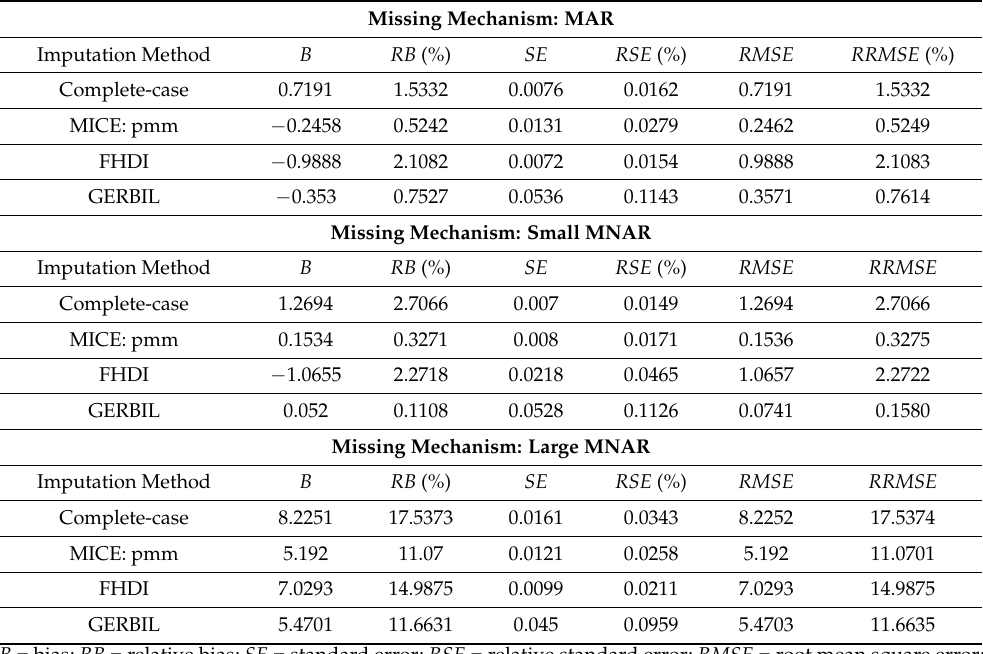
Table 1. Summary of Simulation Results for Mean of BRFSS Variable “Age when Diagnosed with